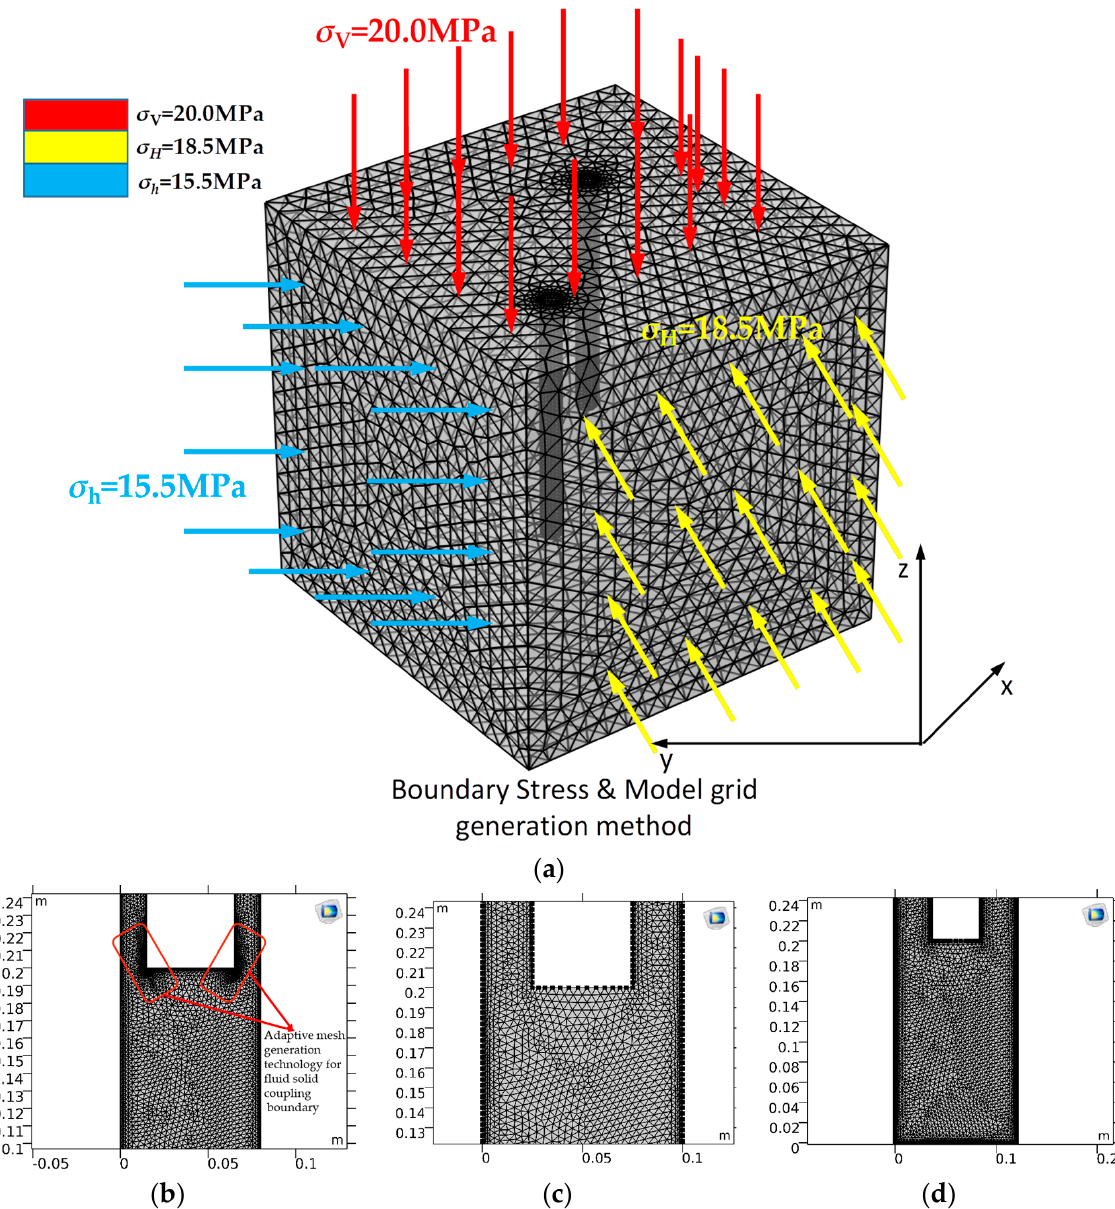
Figure 2. Boundary conditions and mesh generation. ( a ) Boundary load setting method of type I in situ stress rock specimen. ( b ) Grid of 0.08 m borehole. ( c ) Grid of 0.10 m borehole. ( d ) Grid of 0.12 m borehole.